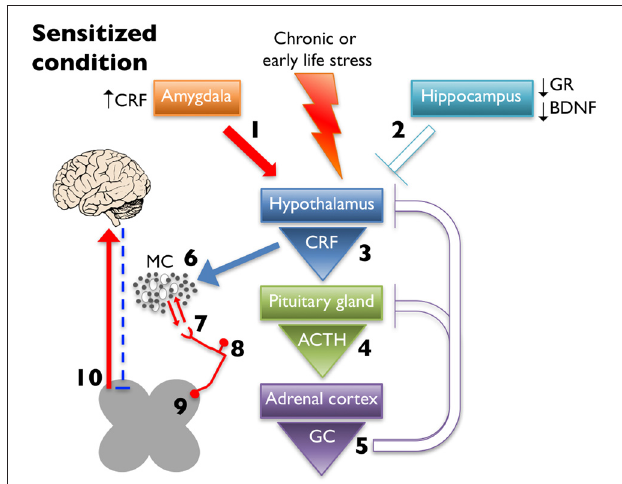
FIGURE 2 | Chronic early life or adult stress leads to alteration in limbic regulation of the HPA axis. This is due to increased CRF expression and drive from the amygdala (1) and decreased glucocorticoid receptor (GR) and brain-derived neurotrophic factor (BDNF) expression in hippocampus, which dampens inhibition (2). These changes ultimately lead to increased CRF release from the hypothalamus (3), increased and prolonged release of ACTH after cessation of the stressor (4), and increased glucocorticoid (GC) production (5) with decreased negative feedback at higher structures. Increased CRF release leads to greater MC activation and infiltration (6) leading to enhanced peripheral nociceptor interaction (7). Increased peripheral drive can lead to hyperalgesic priming (8) and/or wind-up (9), eventually increasing ascending pain signaling, while simultaneously decreasing descending inhibition